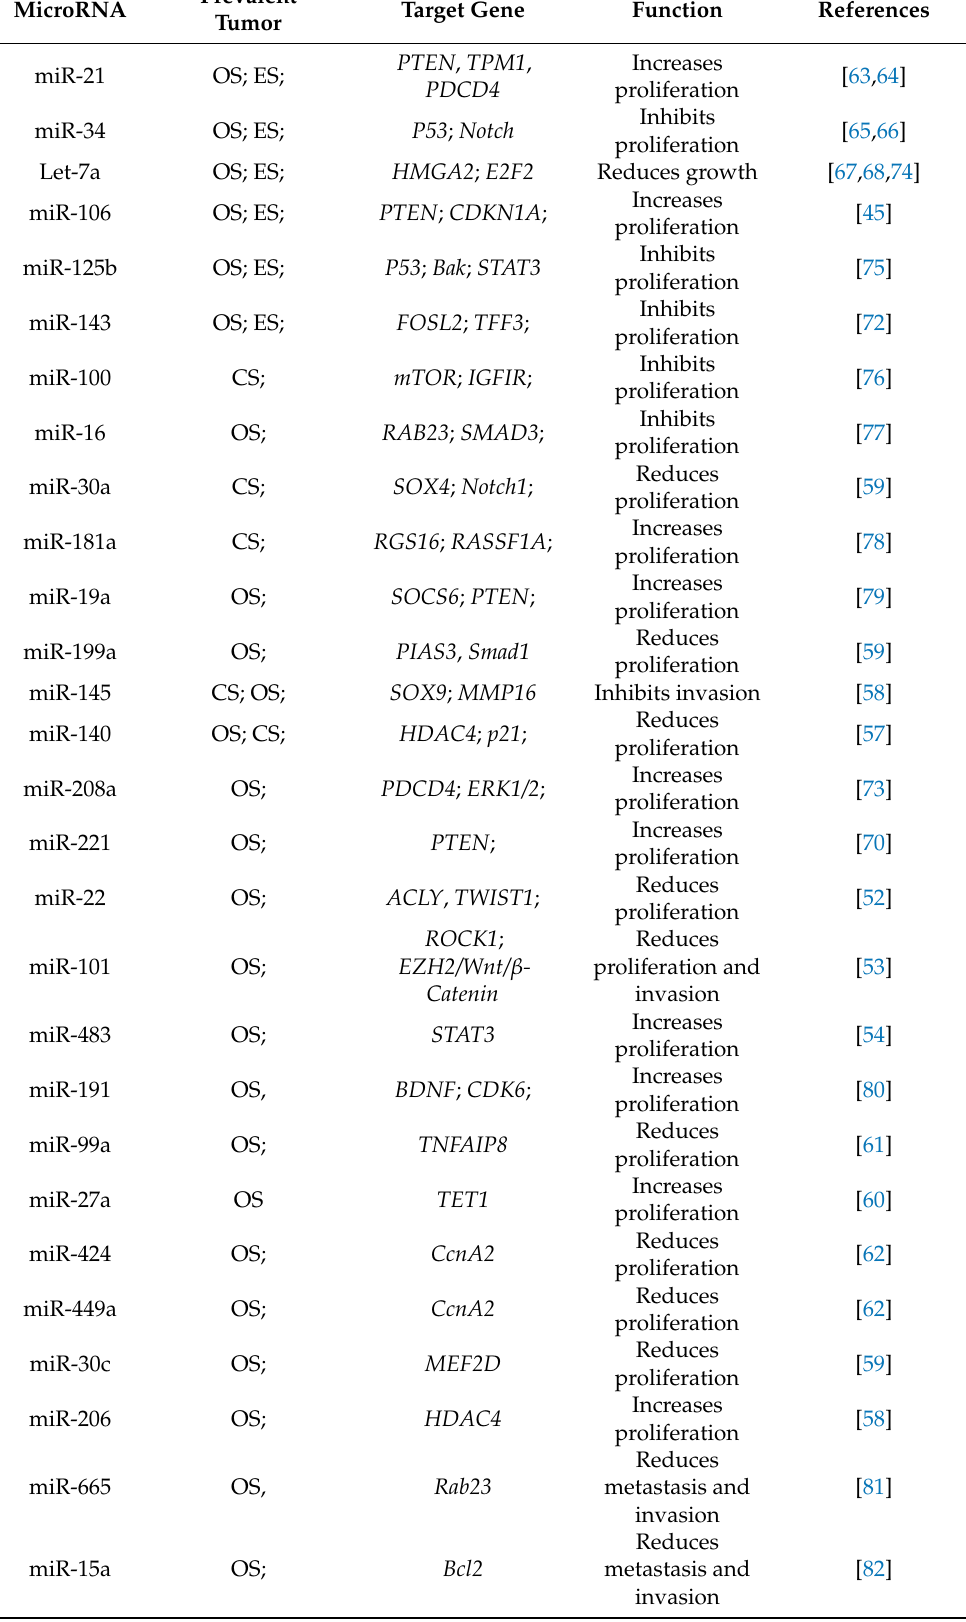
Table 1. List of microRNAs involved in tumor development. The table reports the prevalent bone tumors and target genes as well as their respective